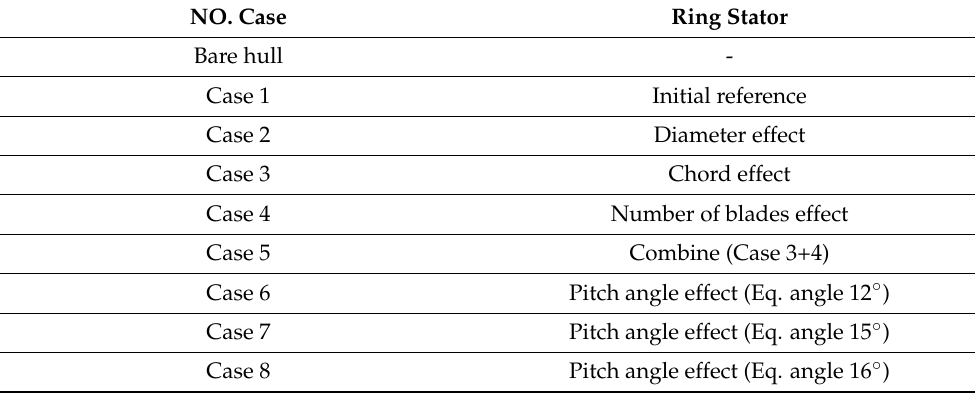
Table 8. Cases of ring stator design.